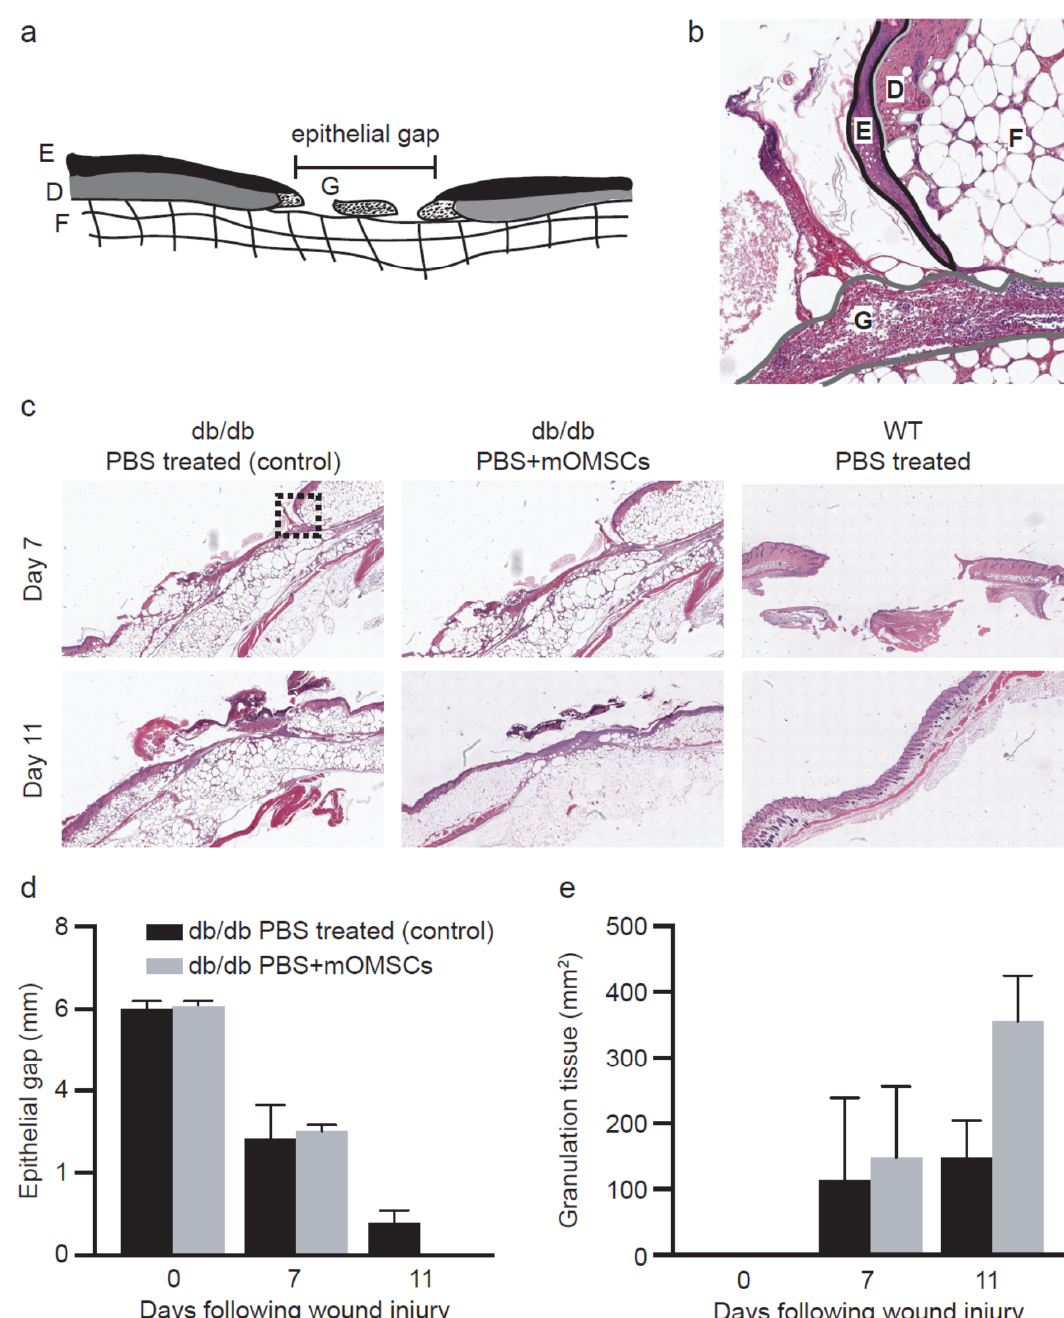
Figure 3. ( a ) Schematic drawing of histological section of the wound model for evaluation of wound healing. Epithelial gap (EG) and total area of granulation tissue were analyzed using digital image analysis software. E = epithelium, G = granulation tissue, D = dermis, F = fat. Epithelial gap was analyzed using digital image analysis software. Granulation tissue area was measured by tracing regions of granulation tissue and calculating pixel area. The sum of the regions was defined as the GT area. ( b ) Histological section of wound in db / db mice. E = epithelium, G = granulation tissue, D = dermis, F = fat. ( c ) Histological comparison of epithelial gap and granulation tissue formation in PBS-treated and PBS + mOMSCs-treated db / db mice and WT control. ( d ) Comparison of epithelial gap in PBS + mOMSCs-treated and PBS-treated db / db mice. EG was assessed at days 0, 7 and 11 after wounding, H&E staining. ( e ) E ff ect of treatment on the rate of GT formation in db / db mice as assessed at days 0, 7 and 11 after wounding